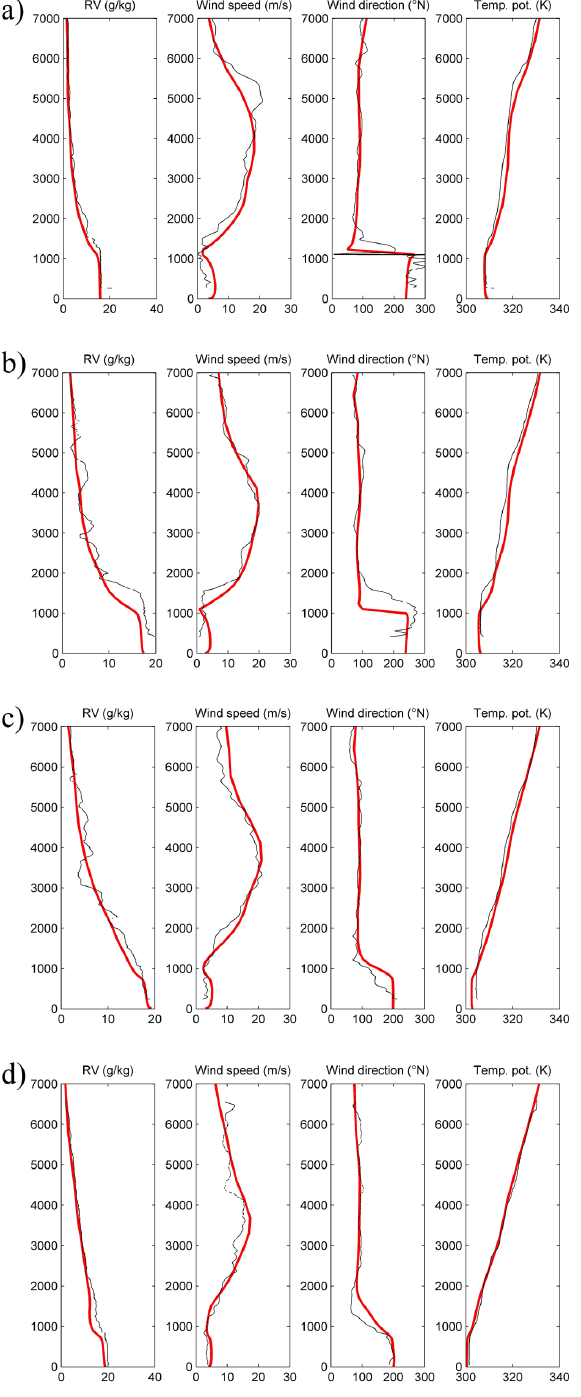
Fig. 7. Vapour mixing ratio (g/kg), wind speed (m/s) wind direction (deg) and potential temperature (K) derived from dropsonde mea- surements (red lines) and the MESONH simulation (black lines) at 12 ◦ N ( a , DS1), at 10 ◦ N ( b , DS2), at 8 ◦ N ( c , DS3) and at 6 ◦ N ( d , DS4) on 13 June.